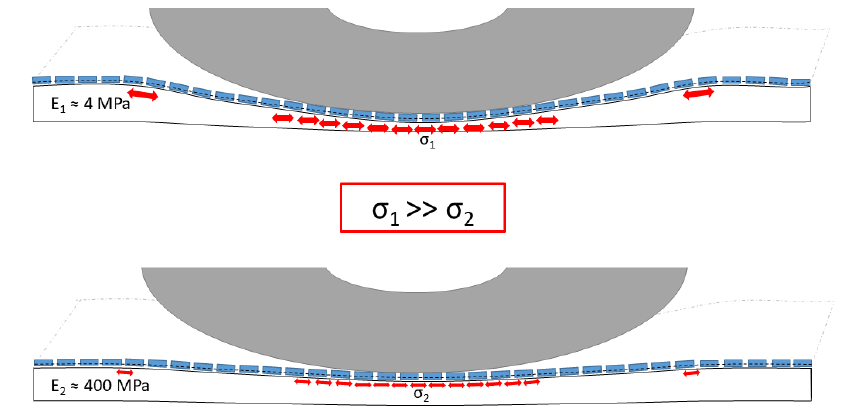
Figure 1. Exemplary representation of the stress input through the texture layer into the absorption layer at different stiffnesses of the substrate. ( Top ) high inclination of texture elements, ( bottom ) low inclination of the texture